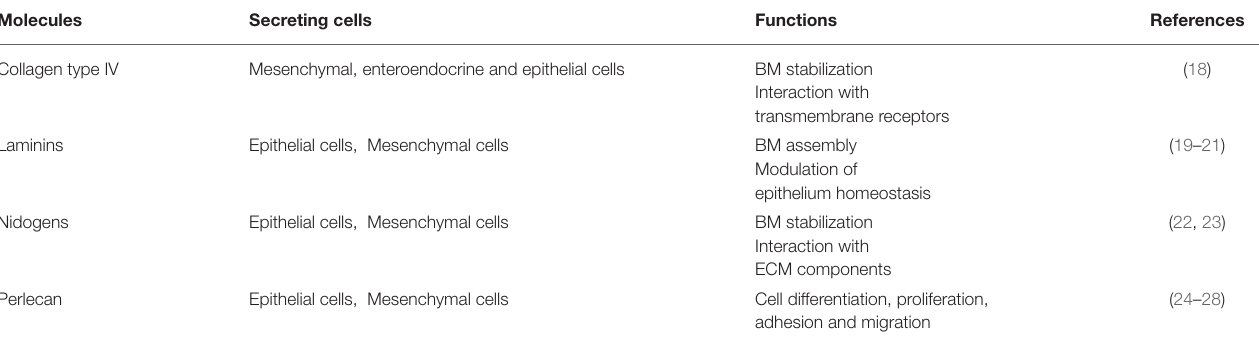
TABLE 2 | The main components of the basement membrane and their